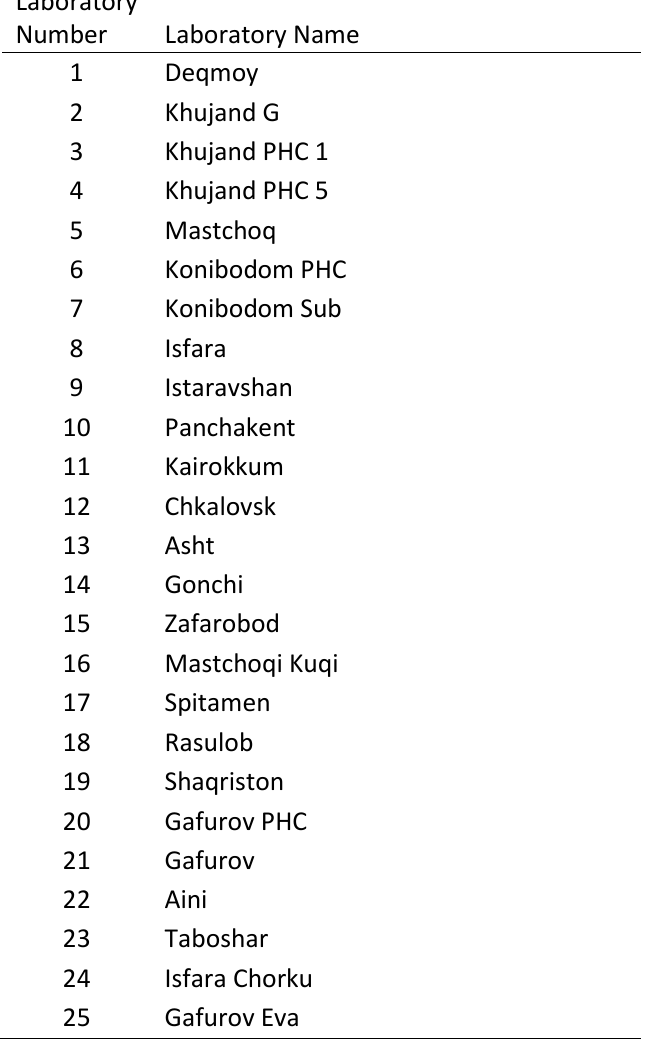
Table S2: Laboratory numbers and corresponding laboratory names